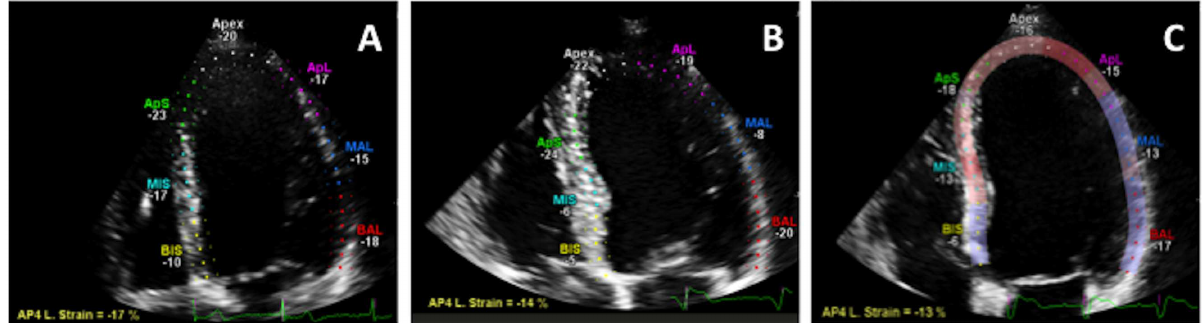
Fig 4. Global longitudinal strain analysis. (A) pre pacemakerimplant, (B) one-month after the initiationof pacingin a patient who developedPIVD and (C) 12 months after pacingin a patient who went on to developPICMP.